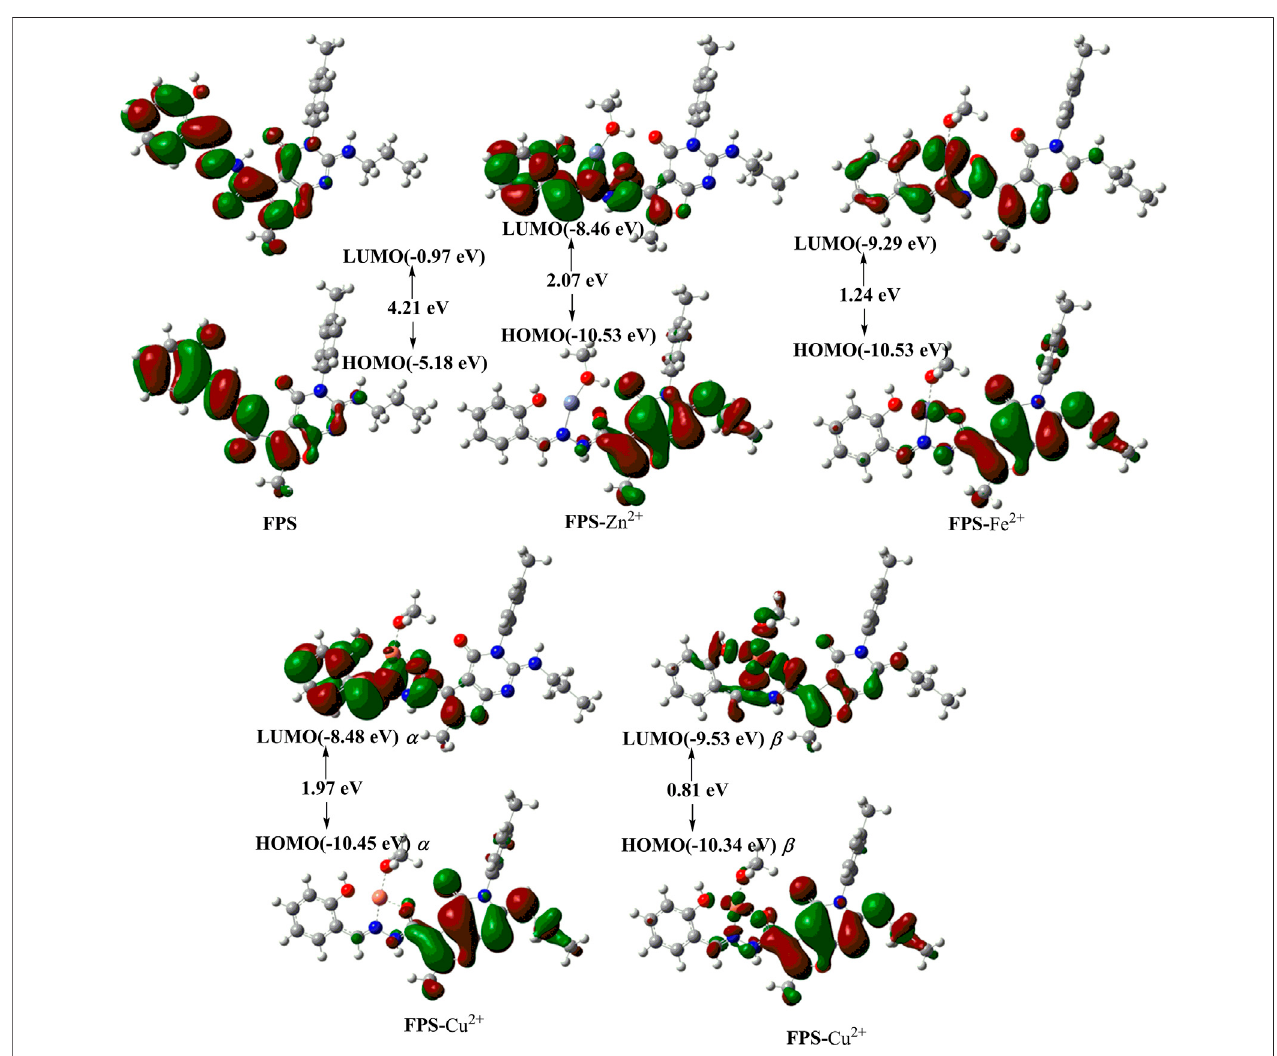
FIGURE 7 | The optimized structures and Frontier molecular orbitals of FPS and FPS-X (X (cid:2) Zn 2+ , Fe 2+ , Cu 2+ ).